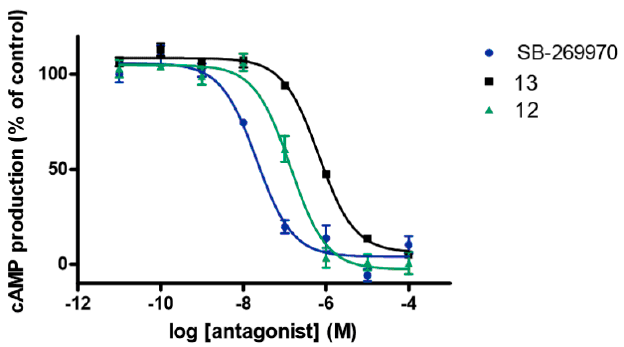
Figure 1. The functional properties of compounds 12 and 13 and a reference antagonist SB-269970 on 5-HT 7 R evaluated using their ability to inhibit cAMP production induced by 5-CT (10 nM) in HEK-293 cells expressing 5-HT 7 R.